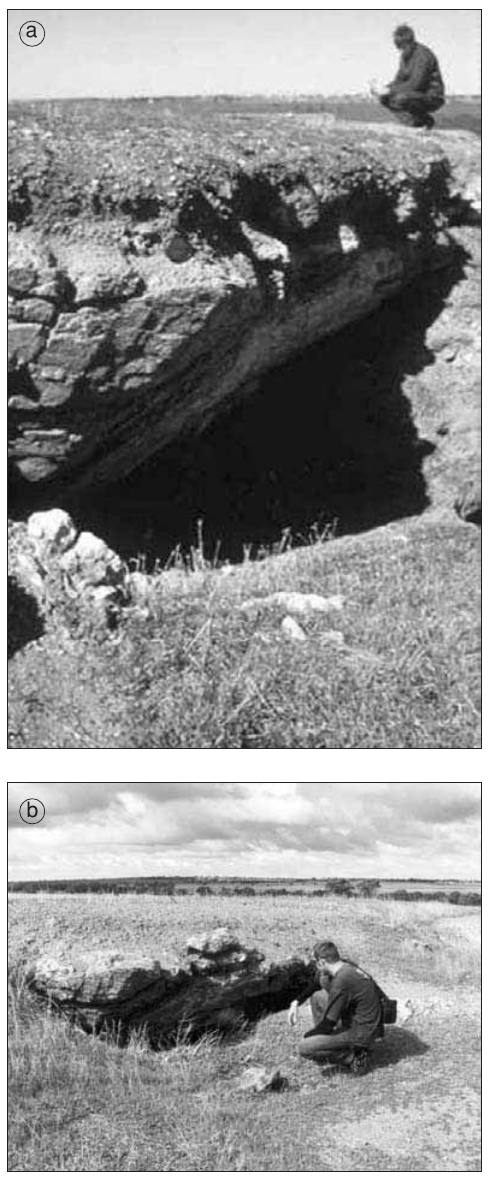
Fig. 2a,b. Images of a section of the 1968 Meckering scarp, looking south. a) Captured in 1970, and b) cap- tured in May 2002. Scarp preservation has been as- sisted by the durable ferricrete and weathered bedrock layer exposed in the hangingwall. Note the rolling to- pography of farmland in the